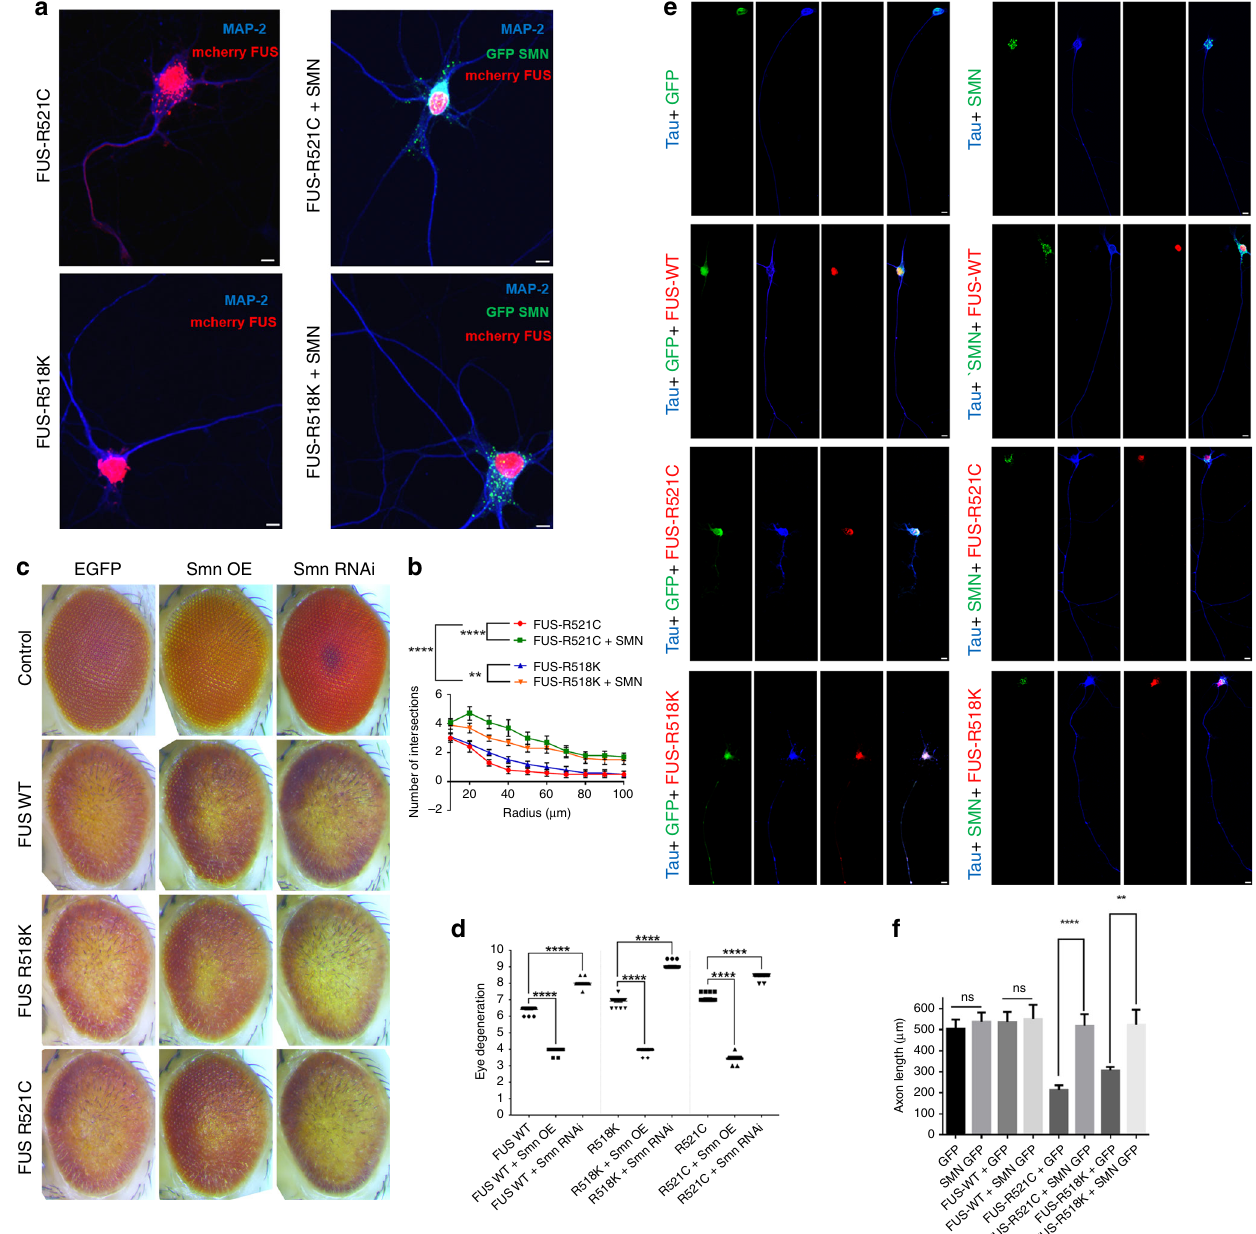
Fig. 8 SMN rescues morphological defects and degenerative phenotype in vivo. Cortical neurons were either transfected with FUS-R521C or FUS-R518K alone or co-transfected with SMN and assessed for morphological changes. a Representative panel of cortical neurons visualized by confocal microscopy for MAP2 (blue), GFP tagged SMN (green), and mCherry tagged FUS-R521C or FUS-R518K (red). Neurons expressing FUS-R521C and FUS-R518K show reduced branching and elongation of neurites. These changes are rescued when SMN is overexpressed. Scale bars = 5 µ m. b Quanti fi cation of the number of intersections at increasing radii from the neuron cell body. Consistent with the qualitative changes shown in a , neurons co-expressing FUS-R521C or FUS-R518K with SMN have a signi fi cant increase in the number of intersections compared with mutant FUS neurons ( n = 10). Two-way ANOVA with Bonferroni ’ s, Tukey ’ s and Sideak ’ s multiple comparisons tests were performed on all groups at each radius measured. Asterisks shown come from the radii measurements with the highest signi fi cant difference between the groups being compared and were consistent with all three multiple comparisons tests performed (** P < 0.01 and **** P < 0.0001). c Knockdown of endogenous Smn strongly enhanced the FUS toxicity in vivo and ectopic expression of Smn strongly suppressed the FUS-mediated external eye degeneration in fl ies. d Quanti fi cation of external eye degenerative phenotype shows that Smn is a strong genetic modi fi er of FUS toxicity in fl ies. e Motor neurons transfected with GFP, GFP-SMN, mCherry tagged FUS-WT, FUS-R521C or FUS-R518K were assessed for axonal growth defects. Representative panel of motor neurons visualized by confocal microscopy for Tau (blue), GFP tagged SMN (green), and mCherry tagged FUS-WT, FUS-R521C or FUS-R518K (red). Neurons expressing FUS-R521C and FUS-R518K show reduced axonal length as shown by Tau immunostaining. SMN overexpression in mutant FUS motor neurons rescues defects in axon growth. Scale bars = 10 µ m. f Quanti fi cation of the axonal length. Consistent with the qualitative changes shown in e , motor neurons co-expressing FUS R521C or FUS-R518K with SMN have a signi fi cant rescue in axon length compared with mutant FUS neurons. Student ’ s t test was used to measure statistical signi fi cance between FUS neurons co-expressing either GFP or